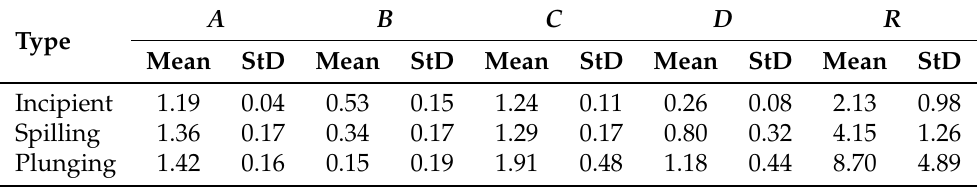
Table 2. Mean and standard deviation for the five characteristic points defining the wave signature. Points A through D have units of acceleration/g, while the R column is the maximum magnitude of pitch and roll rotational rate recorded during the breaking event having units of